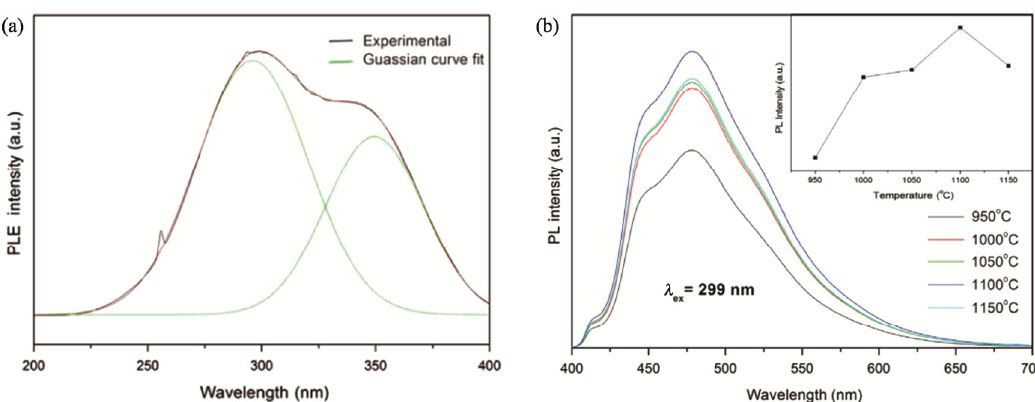
Fig. 8 (a) Excitation spectra of Sr (cid:2870) CeO (cid:2872) phosphor with a Gaussian fit. (b) The emission spectra of Sr (cid:2870) CeO (cid:2872) phosphor sintered at various temperature from 950 to 1150 ℃ under the excitation wavelength at 299 nm . Reproduced with permission from Ref. [158], © Elsevier Ltd and Techna Group S.r.l.